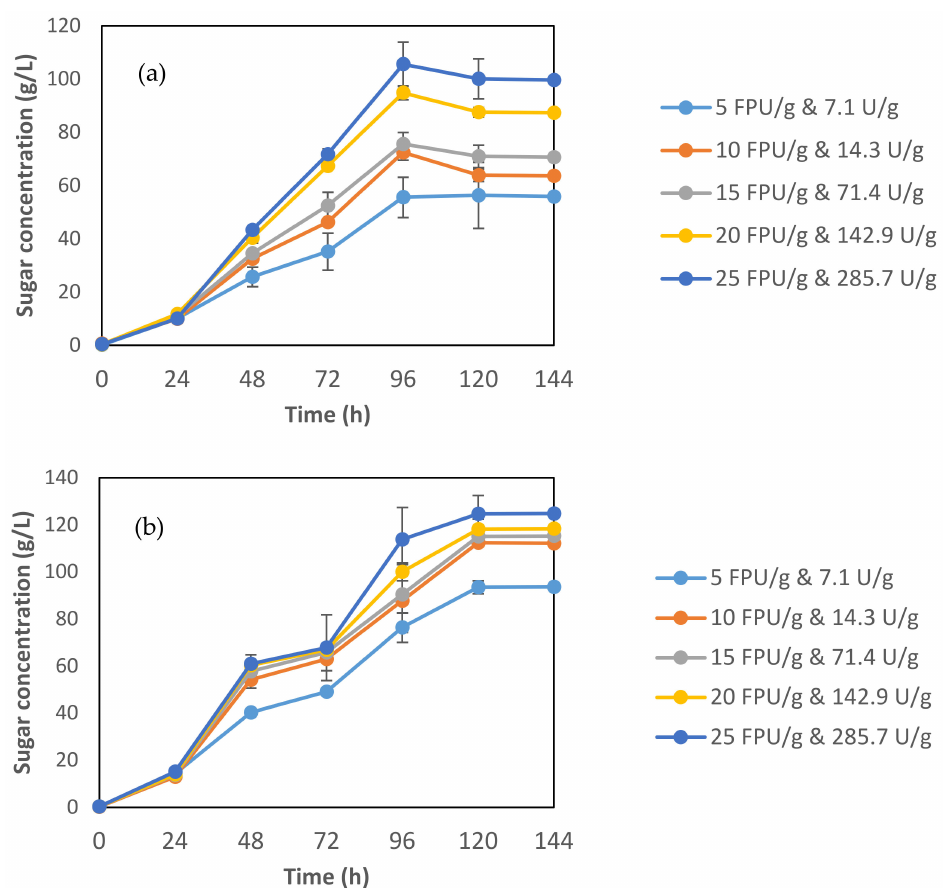
Figure 4. Effect of loading enzymes on the saccharification process: ( a ) initially loaded enzymes only; and ( b ) sequentially loaded enzymes according to substrate